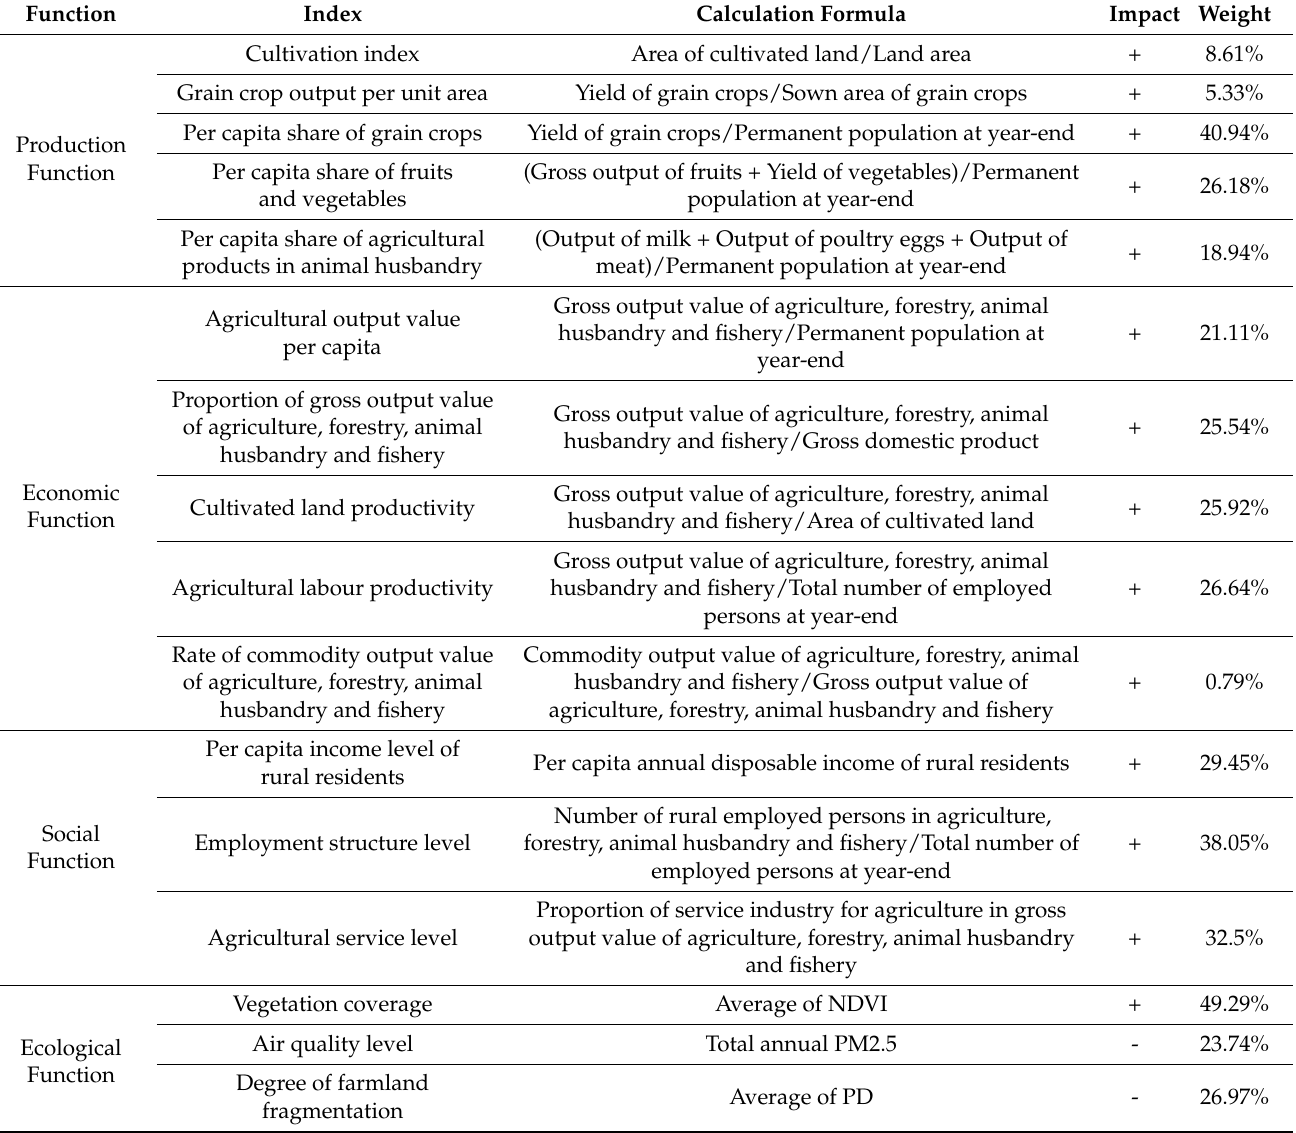
Table 1. Assessing the index system of urban agricultural